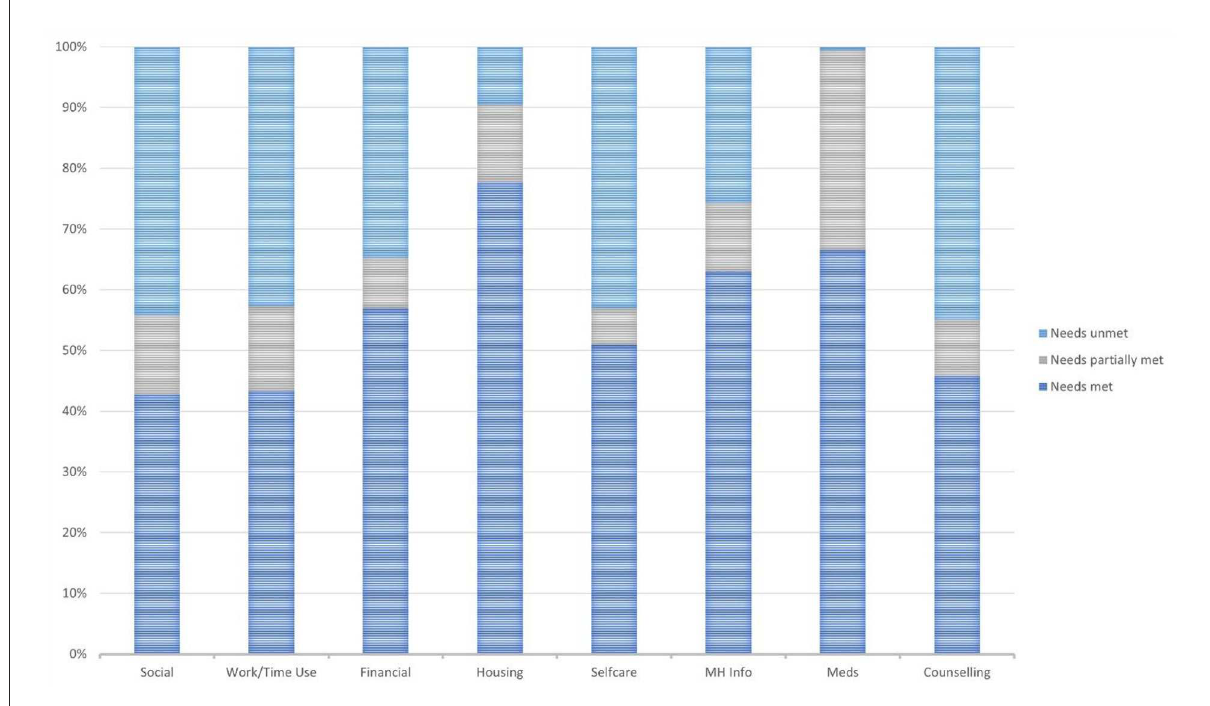
FIGURE1 Percentage of participants who reported a need per PNCQ